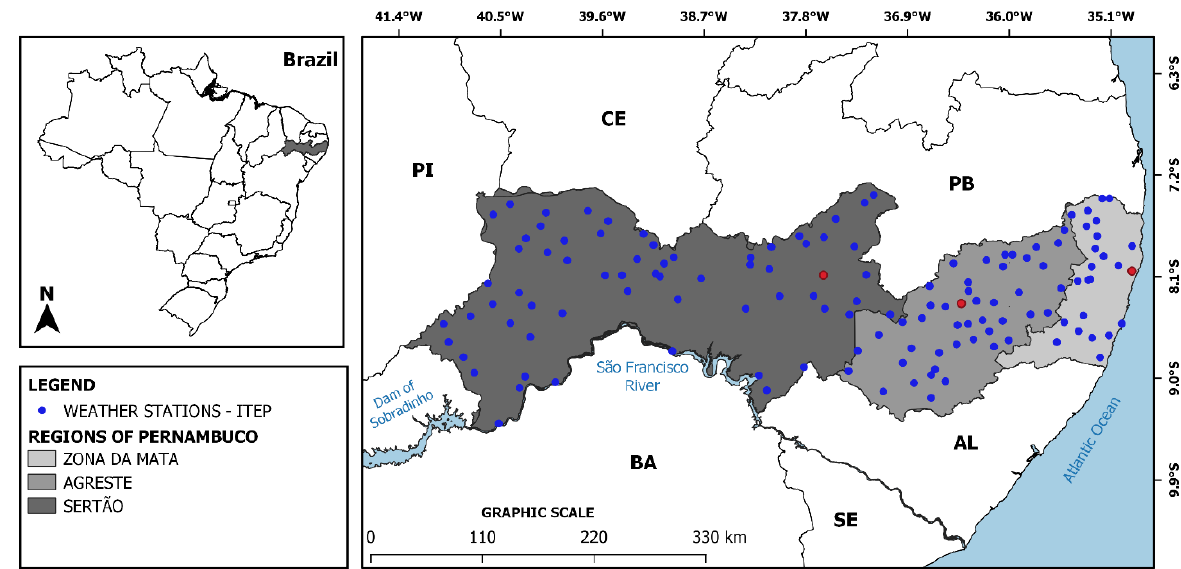
Figure 1. Geographical location of the state of Pernambuco, Brazil, and the spatial distribution of the ITEP weather stations. The three representative stations located in Zona de Mata (lat = −8.05, lon = −34.92, Recife), Agreste (lat = −8.34, lon =−36.43, Belo Jardim), and Sertão (lat = −8.09, lon = −37.65, Custódia) are shown by red circles.